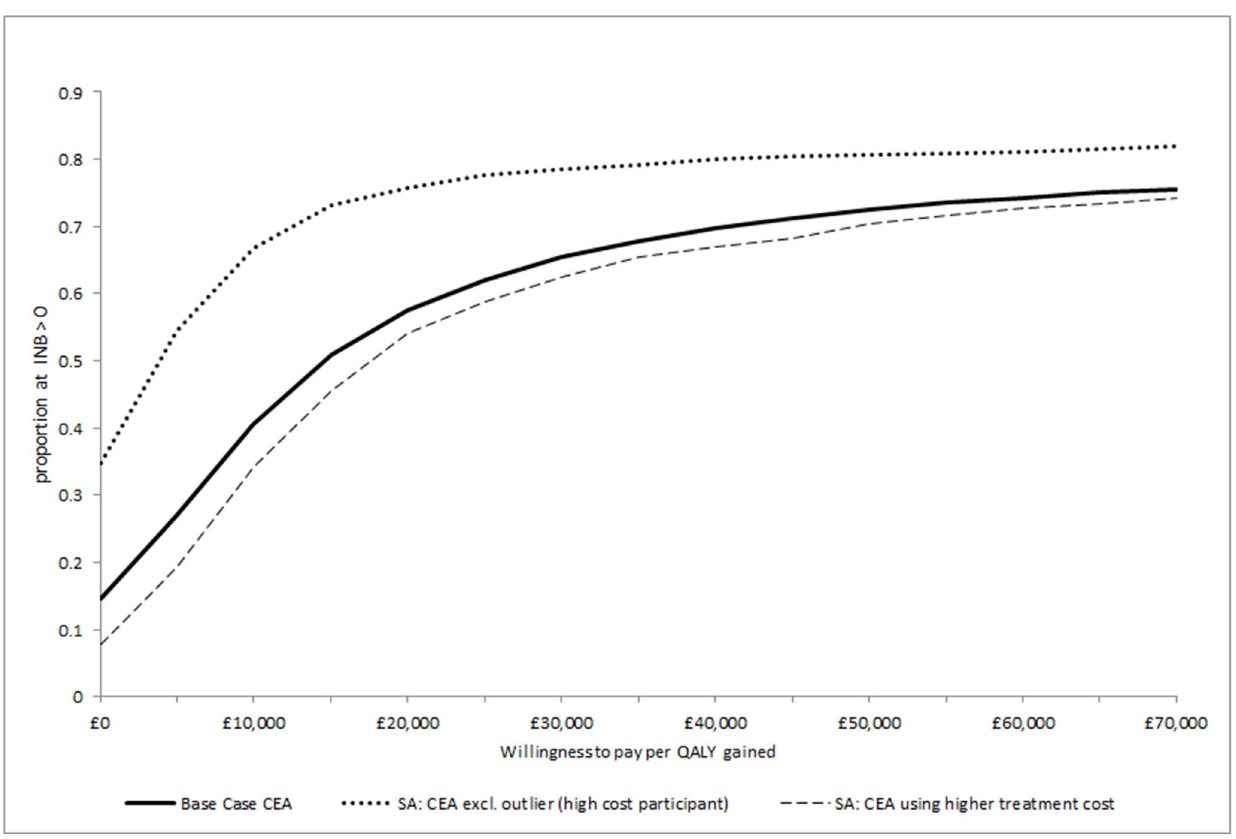
Figure 2. Cost-effectiveness acceptability curves.